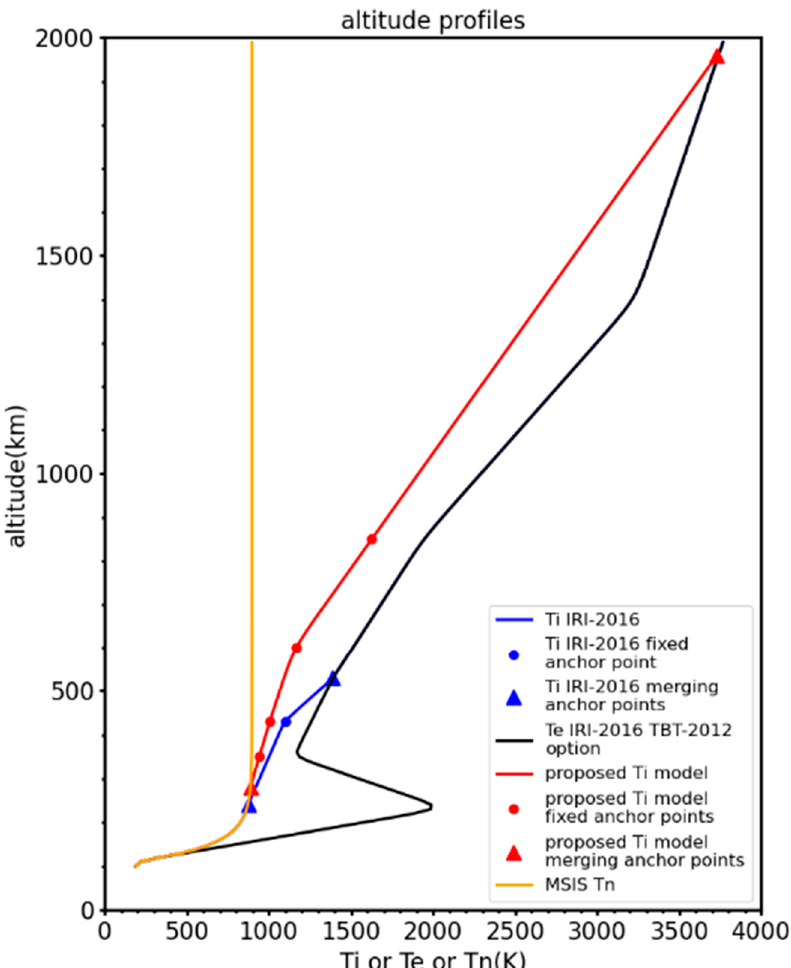
Figure 4. Example of altitude profiles (case for 21 March 2016; PF10.7 = 92; Solar local time 12 h, geographical latitude = 20°; geographical longitude = 0°) from the proposed Ti model (red line; 4 red circles represent 4 fixed anchor points with altitudes of 350, 430, 600 and 850 km; 2 red triangles symbolize additional anchor points with variable altitudes-lower one a tangent point on the Tn profile (orange line) and higher one an intersection with the Te profile (black line). The corresponding Ti profile computed from the IRI-2016 model is shown in the blue color (one fixed anchor point at 430 km height-circle; two anchor points for the connection with Tn and